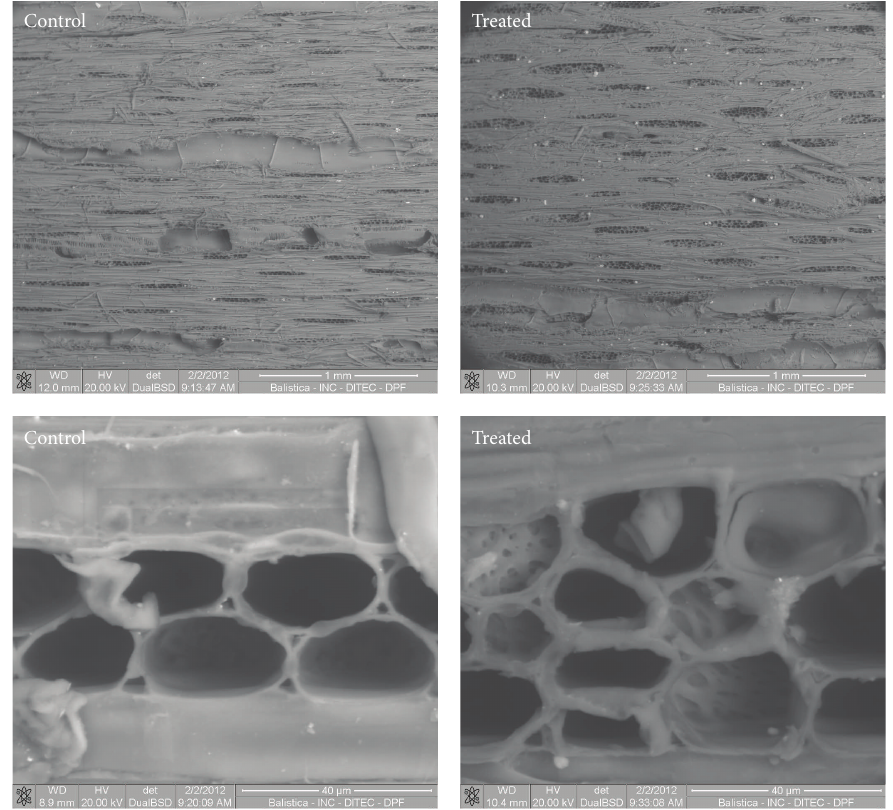
Figure 3: Images of the surface of the samples made by